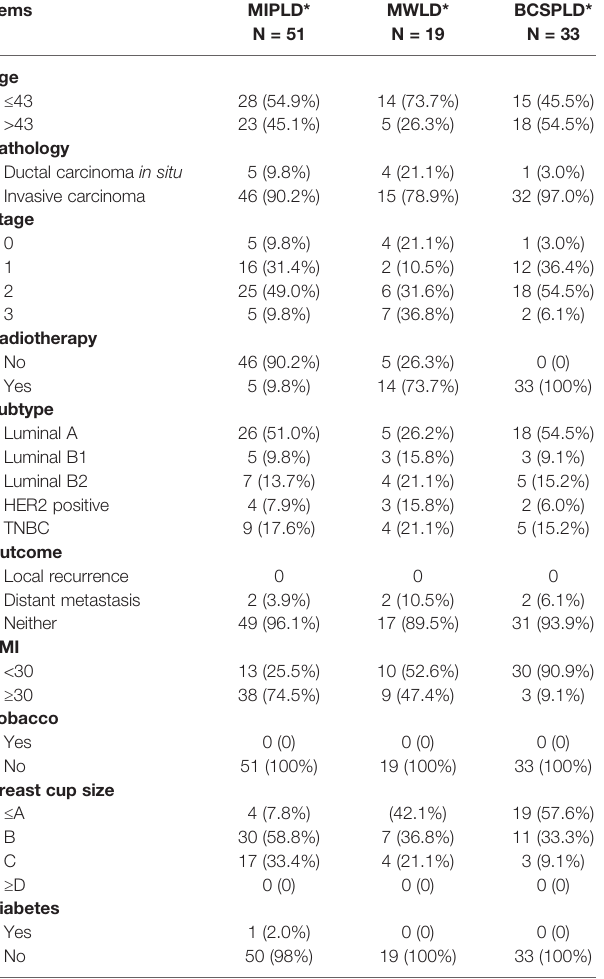
TABLE 1 | Characteristics of patients. TABLE 2 | BREAST-Q reconstruction module demographics.